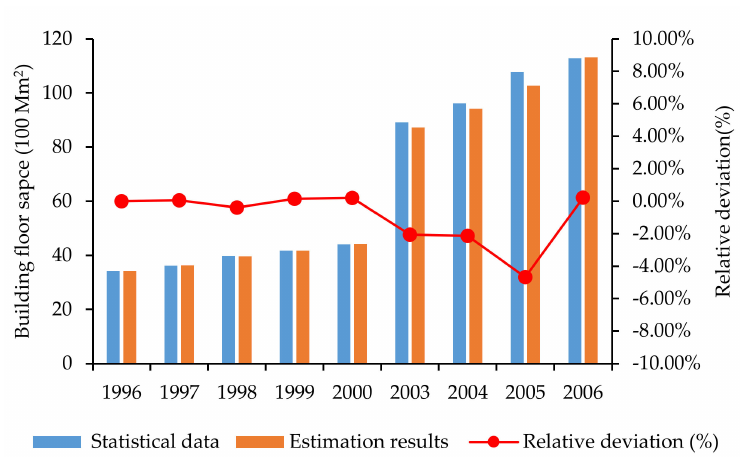
Figure 9. The deviations between the model results and the statistical data as for urban residential floor space from 1996 to 2006 excluding 2001 and